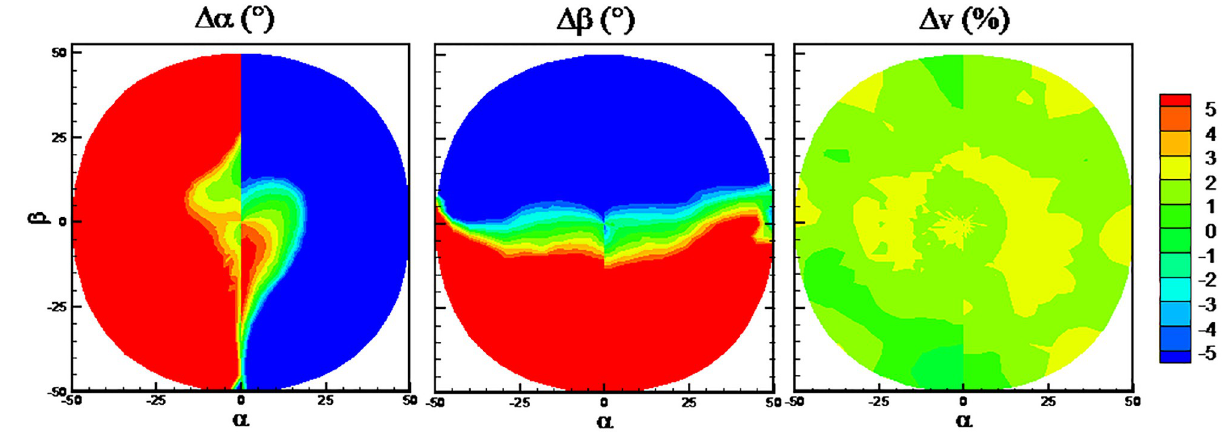
Fig 23. Error distributions with SVM algorithm.